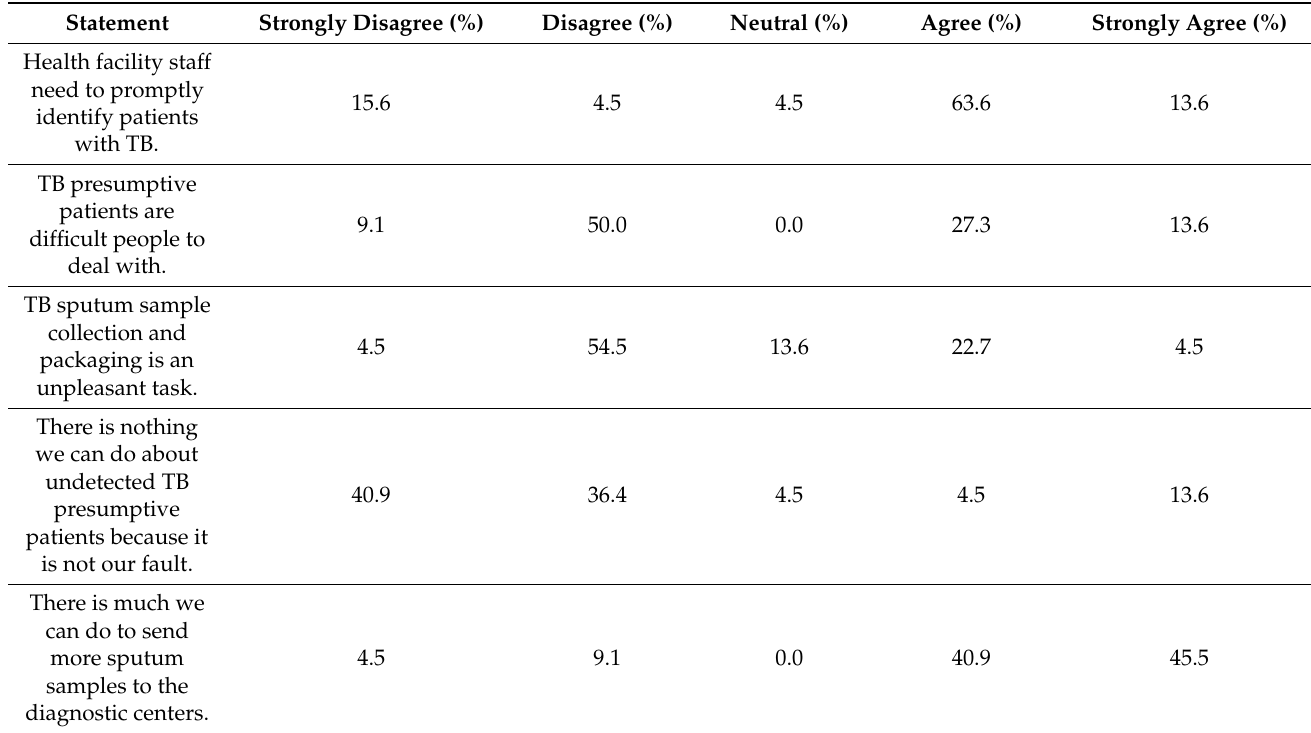
Table 2. Attitudes toward intensified TB case finding among TB service providers from ten non- diagnostic facilities in Mpulungu District, October 2018 ( N = 22).